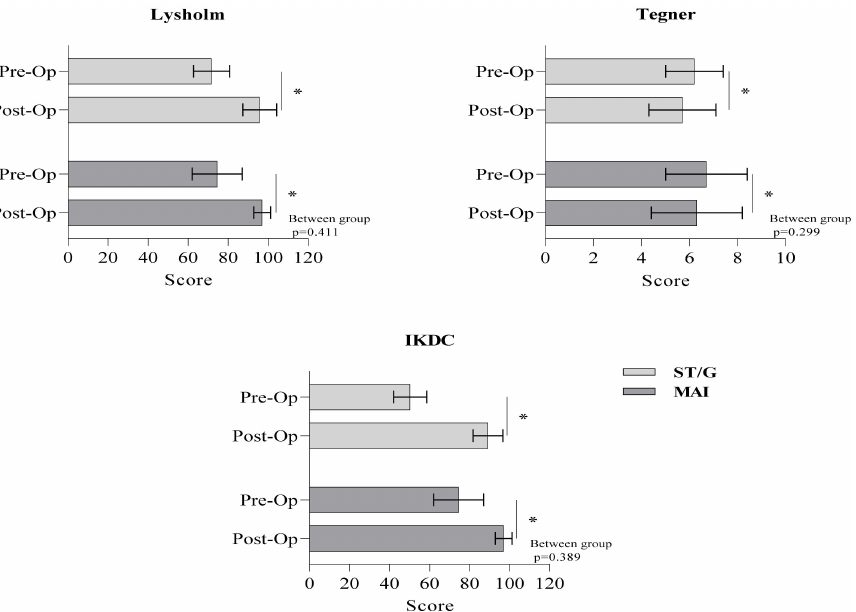
Figure 2. Comparison of pre-operative and post-operative levels of Lysholm, Tegner, and IKDC scores between techniques. * p < 0.05.